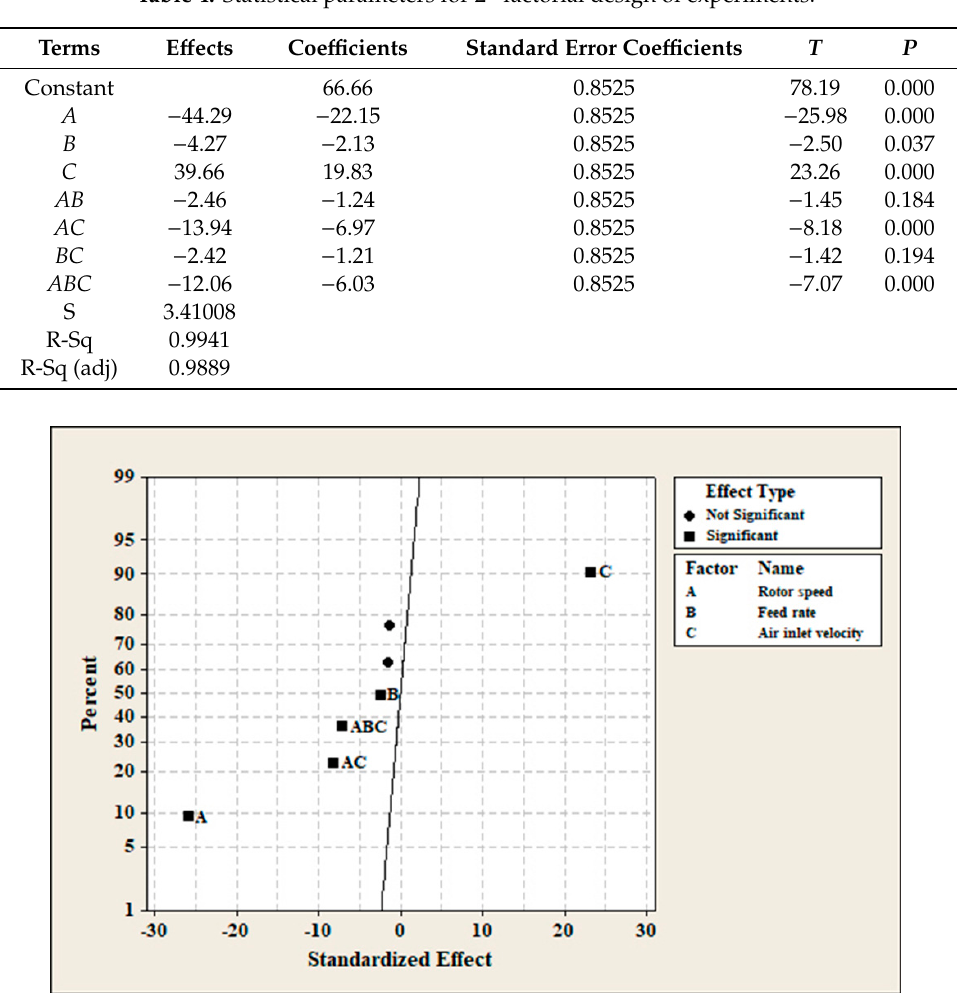
Figure 4. Normal probability plot of standardized effects for cut size (at α = 0.05).